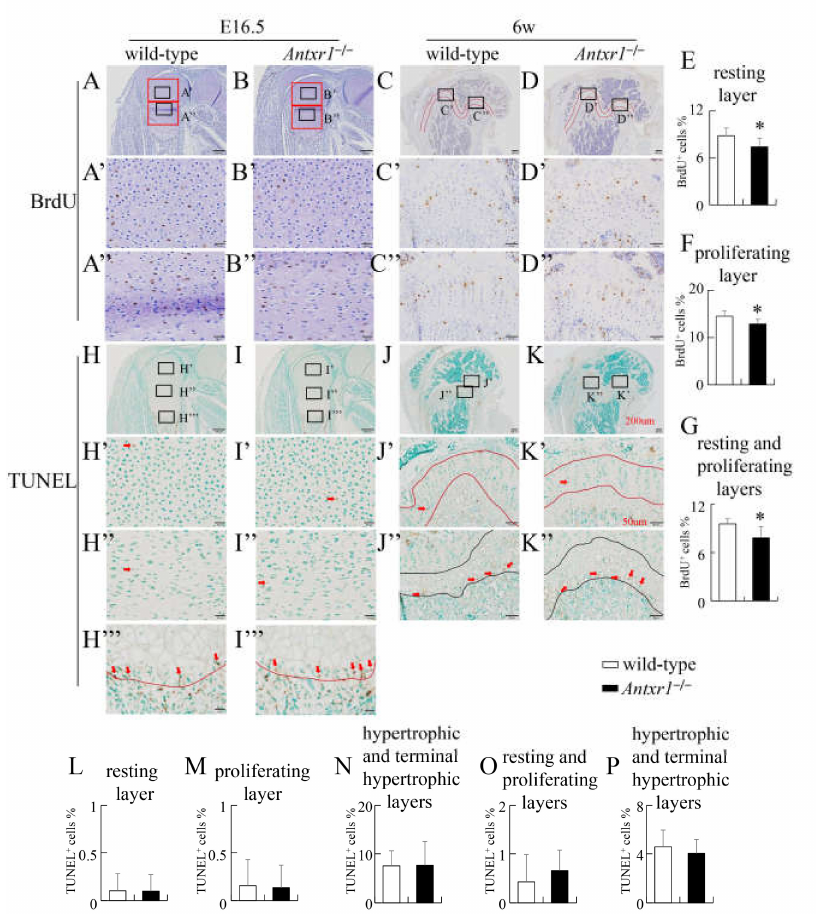
Figure 6. Proliferation and apoptosis of chondrocytes in wild-type and Antxr1 – / – mice at E16.5 and 6 weeks of age: ( A – D ) BrdU staining using femoral sections from wild-type ( A , C ) and Antxr1 – / – ( B , D ) mice at E16.5 ( A , B ) and 6 weeks of age ( C , D ). The boxed regions in A – D are magnified in A’ – D’ and A” – D” . ( E – G ) The frequencies of BrdU-positive chondrocytes in the resting ( E ) and proliferating ( F ) layers (red boxes in A and B ) at E16.5 and those in the resting and proliferating layers (the area between two red lines in C and D ) at 6 weeks of age ( G ). The layer with columnar alignment of chondrocytes without hypertrophy was regarded as a proliferating layer, and the epiphyseal part of the proliferating layer was regarded as a resting layer. ( H – K ) TUNEL staining using femoral sections from wild-type ( H , J ) and Antxr1 – / – ( I , K ) mice at E16.5 ( H , I ) and 6 weeks of age ( J , K ). The boxed regions in H – K are magnified in H’ – K’ , H” – K” , H”’ , and I”’ . The red arrows in H’ – I”’ indicate TUNEL-positive chondrocytes. ( L – P ) The frequencies of TUNEL-positive chondrocytes in the resting layers ( H’ , I’ , L ), proliferating layers ( H” , J” , M ), and hypertrophic and terminal hypertrophic layers (the upper part of the line in H”’ and I”’ ) ( N ) at E16.5 and those in the resting and proliferating layers (the area between the two red lines in J’ and K’ ) ( O ) and hypertrophic and terminal hypertrophic layers (the area between the two black lines in J” and K” ) ( P ) at 6 weeks of age. The layer with chondrocyte hypertrophy was regarded as hypertrophic and terminal hypertrophic layers. Scale bars: 200 µ m ( A – D , H – K ), 50 µ m ( A’ – D’ , A” – D” , H’ – K’ , H” – K” , H”’ , I”’ ). The number of mice analyzed: BrdU staining at E16.5,